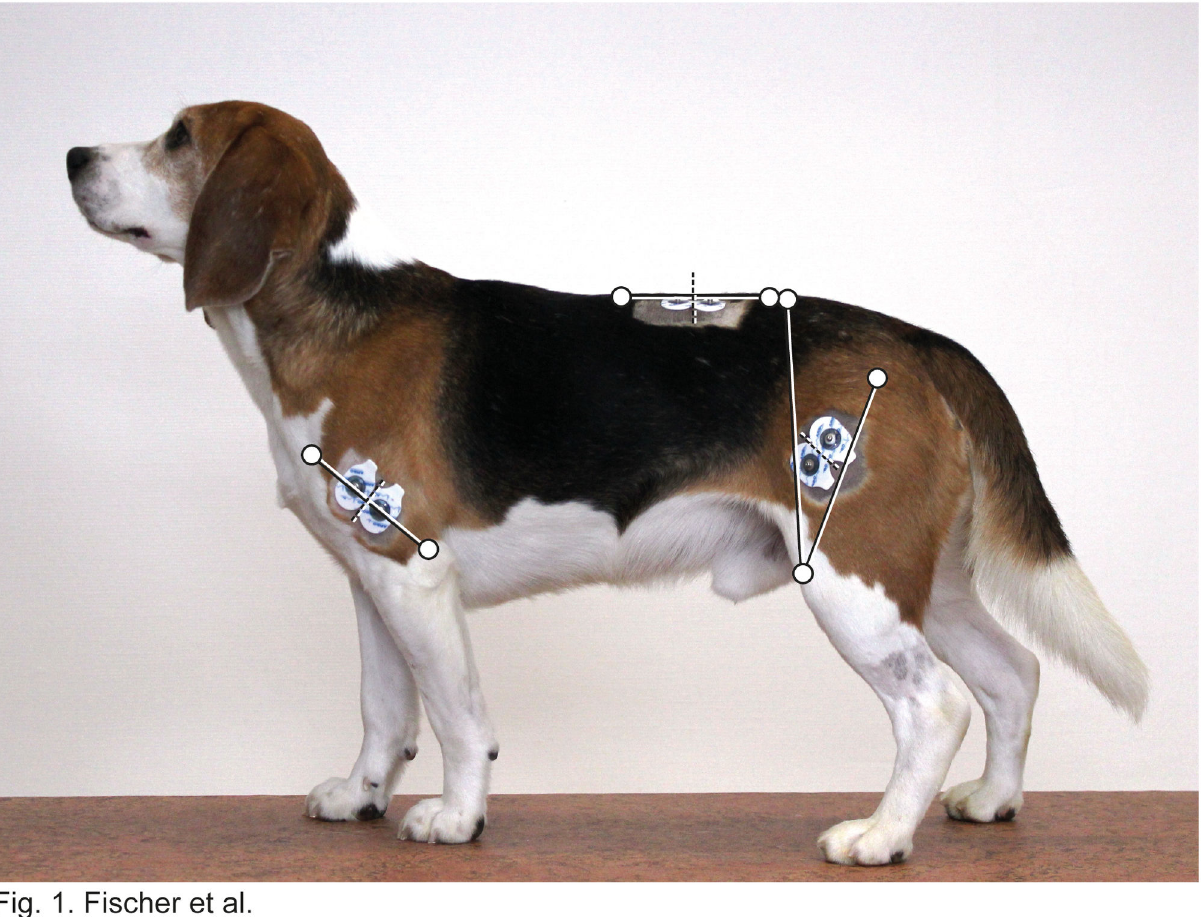
Figure 1. One of the subjects partially instrumented to illustrate the electrode positioning (for details on the skeletal landmarks, see Material &